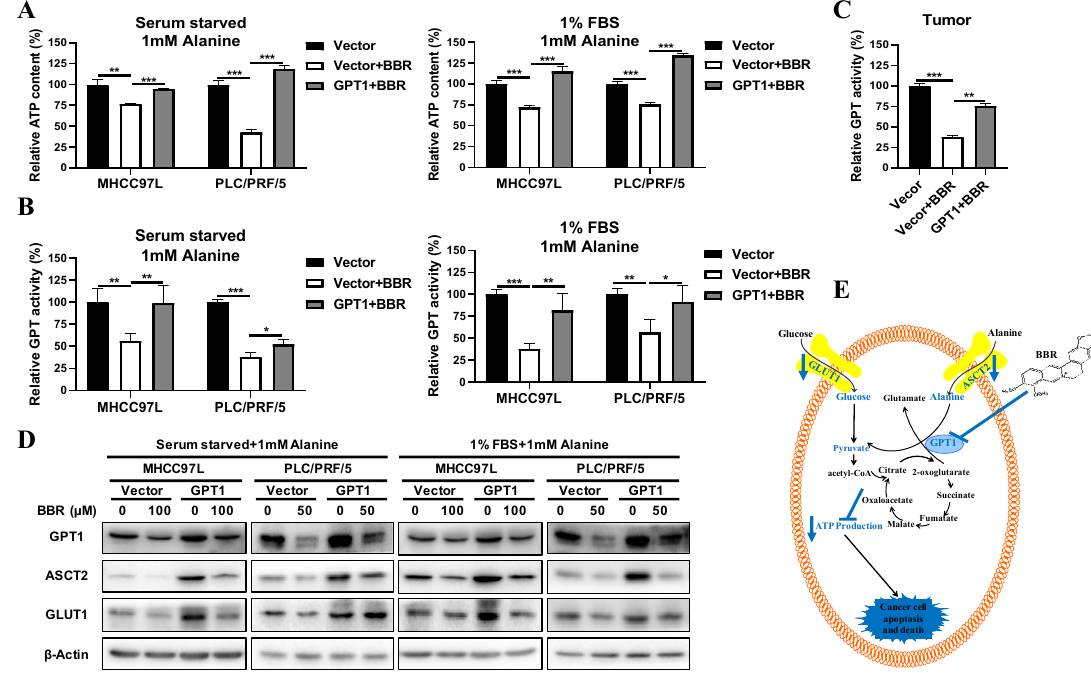
Figure 6. BBR-suppressed GPT1 reversed the dysregulated energy homeostasis in HCC. ( A ) The ATP content levels of MHCC97L and PLC / PRF / 5 cells with or without stable GPT1 overexpression under alanine-supplemented conditions after BBR treatment for 24 h. ( B ) The GPT activity levels of MHCC97L and PLC / PRF / 5 cells with or without stable GPT1 overexpression under alanine-supplemented conditions after BBR treatment for 24 h. ( C ) The GPT activity levels of the tumor with or without stable GPT1 overexpression at the end of BBR treatment ( n = 5). ( D ) The representative Western blot panels of GPT1, ASCT2, and GLUT1 protein levels of MHCC97L and PLC / PRF / 5 cells with or without stable GPT1 overexpression under alanine-supplemented conditions after BBR treatment for 24 h. ( E ) Schematic illustration of the regulatory mechanism underlying the inhibitory e ff ects of BBR on HCC. All experiments were conducted in triplicate unless otherwise stated. * P < 0.05, ** P <